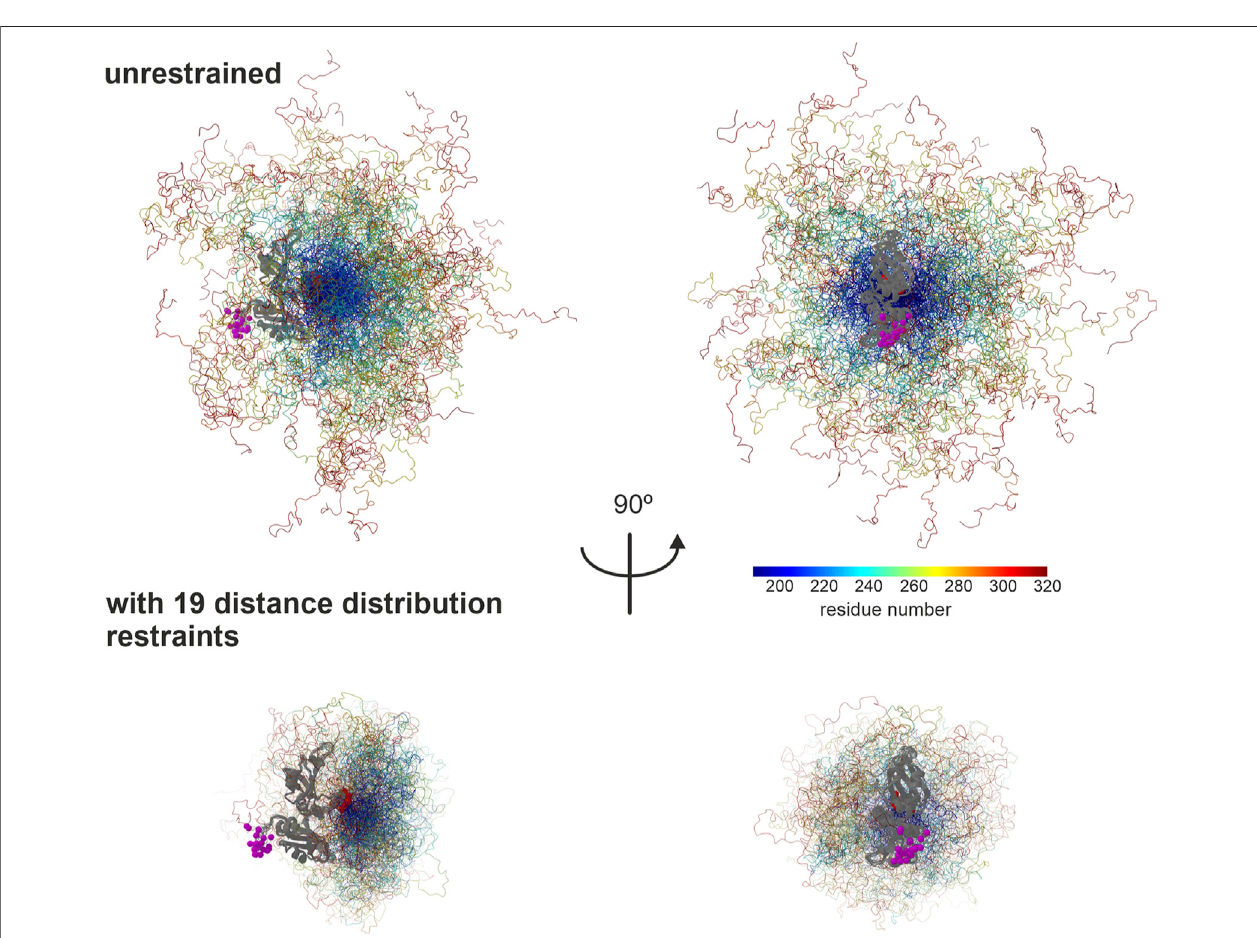
FIGURE7| Ensemble modelfortheLCDofhnRNP A1.ThetwoRRMs (PDB 2lyv,Barraudand Allain,2013)areshowningray,withtheNterminus totheleftinthe left panel and to the front in the right panel. RRM 1 is on the bottom and RRM 2 on the top. Residues in the LCD are rainbow color coded from blue (residue 188) to red (320).Populationofconformersisencodedbycoilthickness,withthemostpopulatedconformerhavingathicknessof0.25 Å.CAatomsoftheN-terminusofRRM1are shown as purple spheres with radius 1.5 Å and CA atoms of the C-terminus of RRM 2 are shown as maroon spheres with the same radius. Visualization by ChimeraX (Goddard et al., 2018) via an MMMx